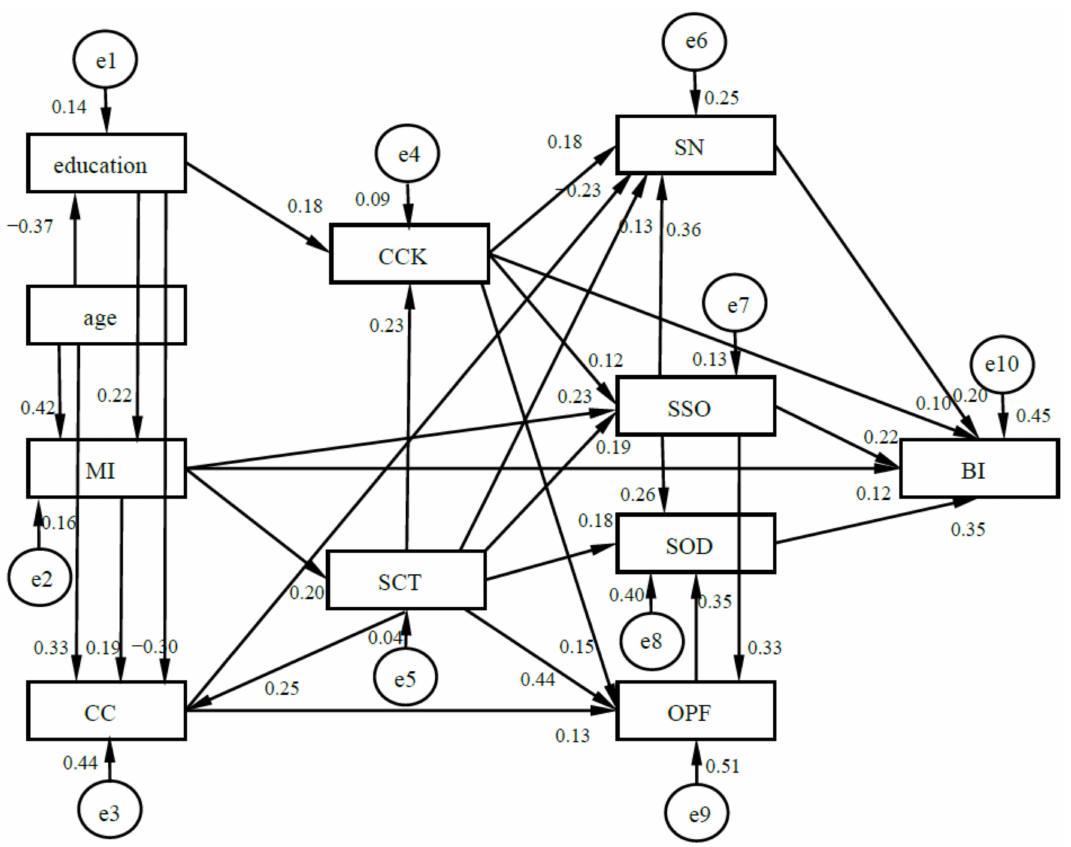
Figure 3. Results model of the BI of cervical cancer screening ( n = 496). Note: MI, CC, SN, SSO, SOD, and OPF are the abbreviations of monthly income, childbearing condition, screening necessity, support from significant others, subjectively overcoming di ffi culties, and the objective promotion